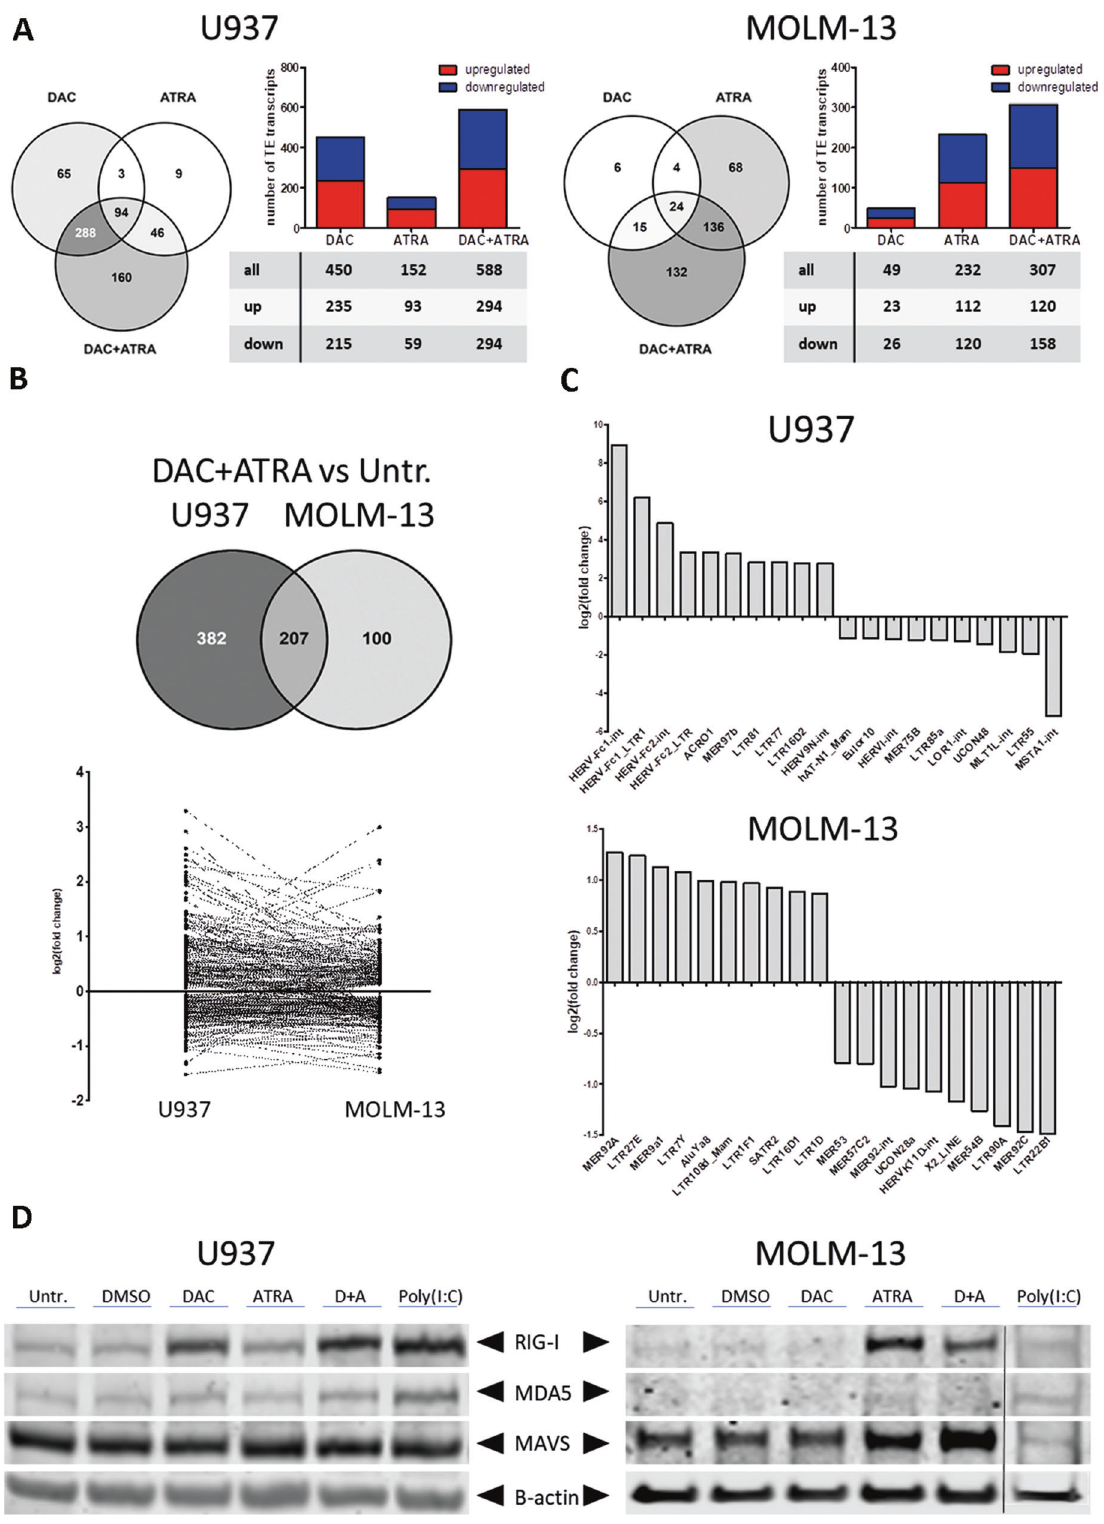
might explain the limited antiproliferative effect observed in THP1 and HL-60 cells compared to U937. The cooperative effects of the HMA + retinoid in U937 cells are in line with emerging clinical results of a post hoc analysis of the DECIDER cohort, where patients with TP53 mutations had a